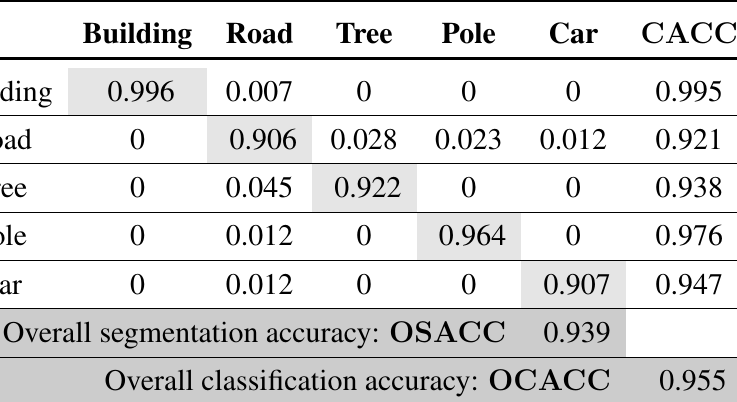
Table 3. Classification results of data set 2 with the new evaluation